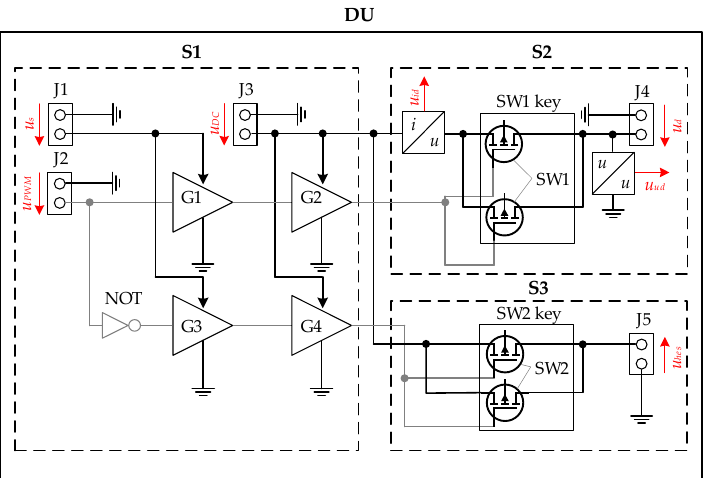
Figure 2. Architecture of the driver unit.